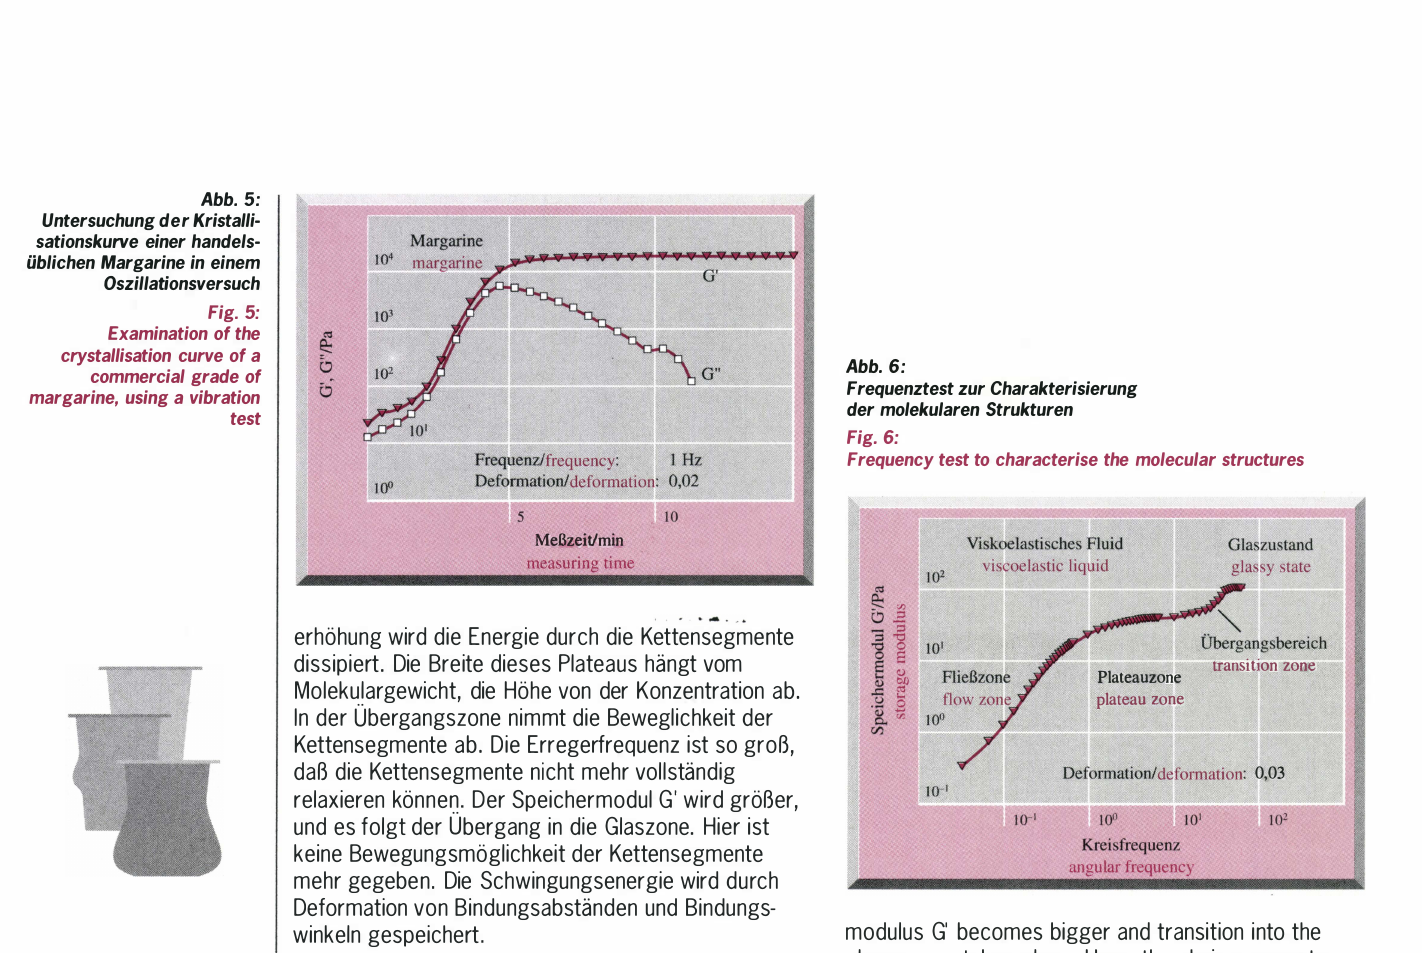
Kreisfrequenz angular frequency